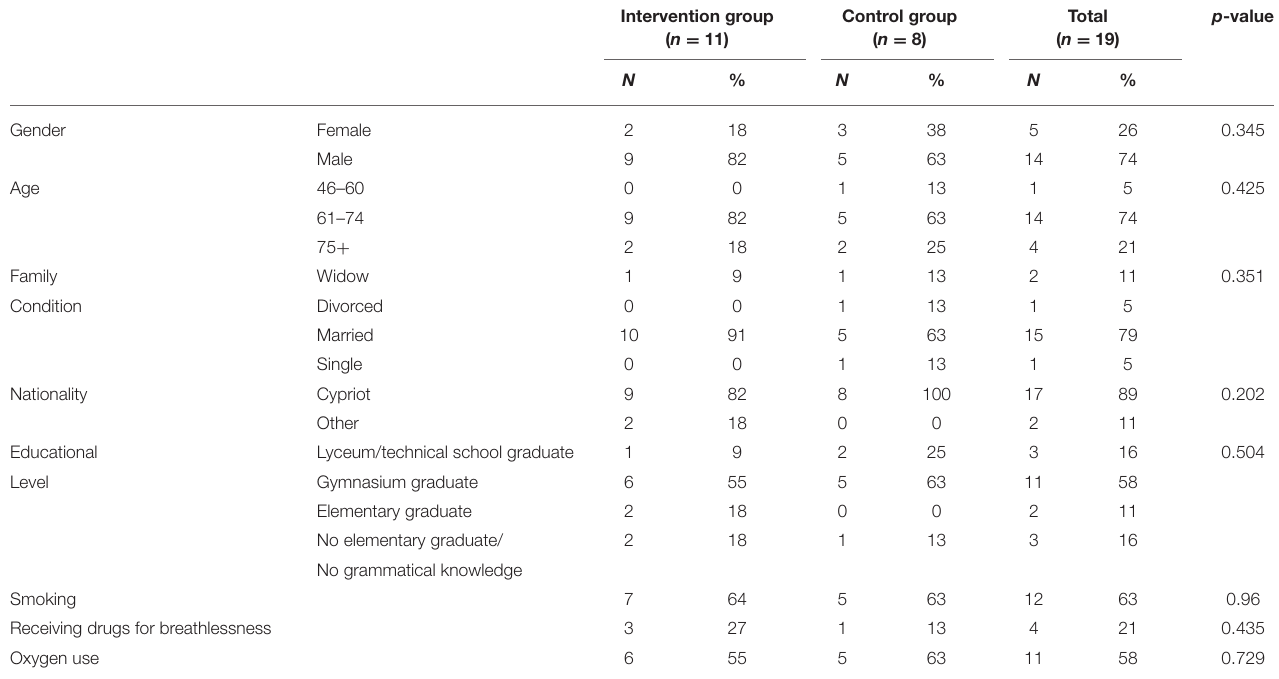
TABLE 1 | Demographic data of the two groups.